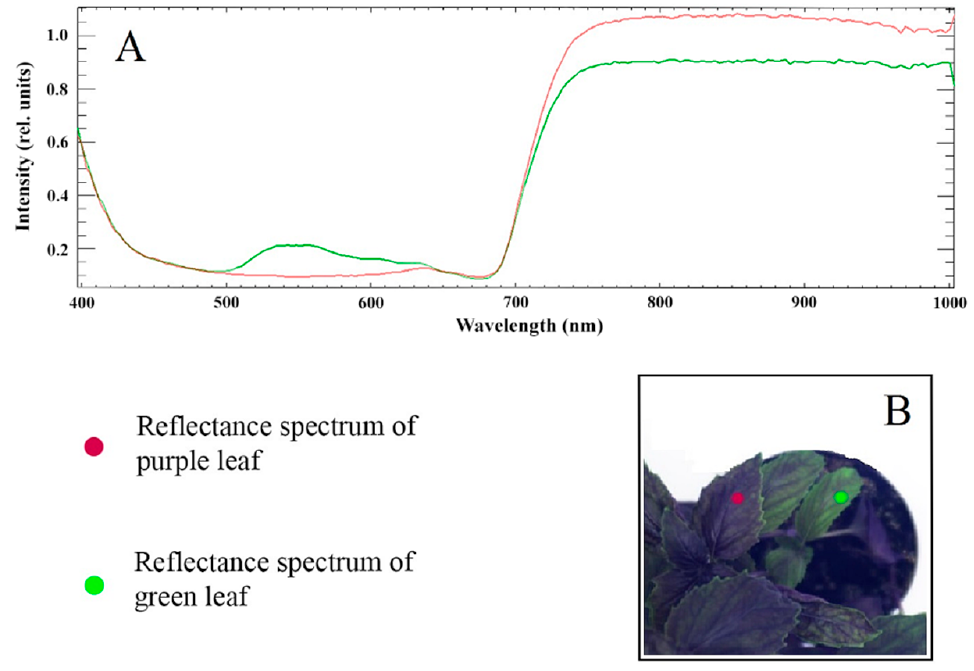
Figure 5. Reflection spectra ( A ) and appearance ( B ) of purple and green basil leaves of “Markus” on 30th day of cultivation.